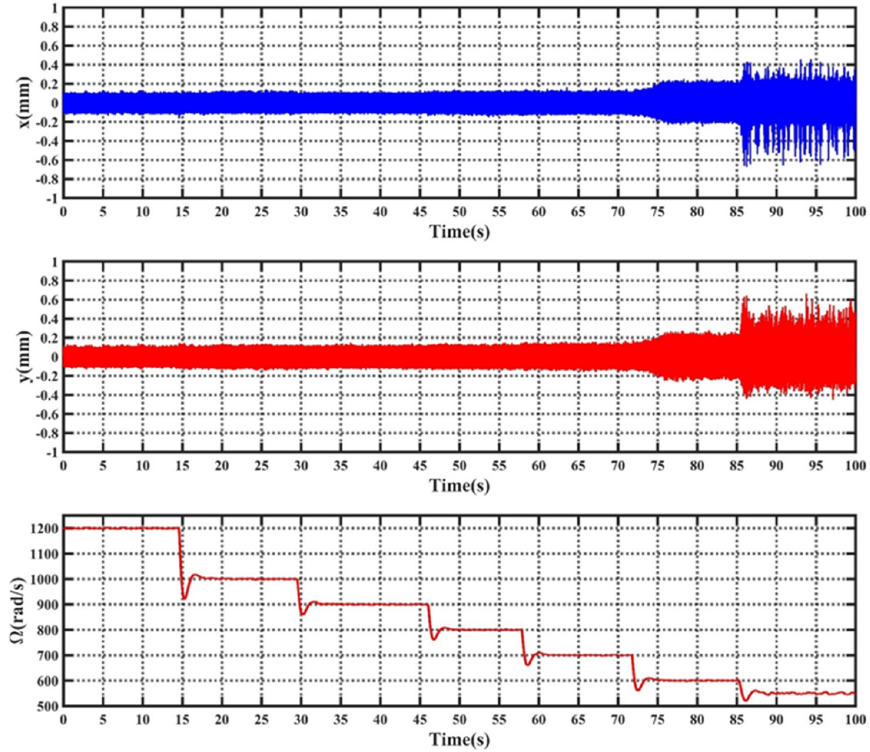
Figure 14. Experimental results: when Z s = − 0.3 mm, the radial vibration displacements in x - and y - directions are presented corresponding to different rotary speeds.